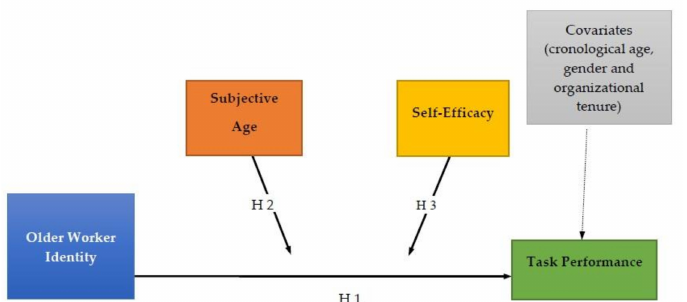
Figure 1. Model of proposed